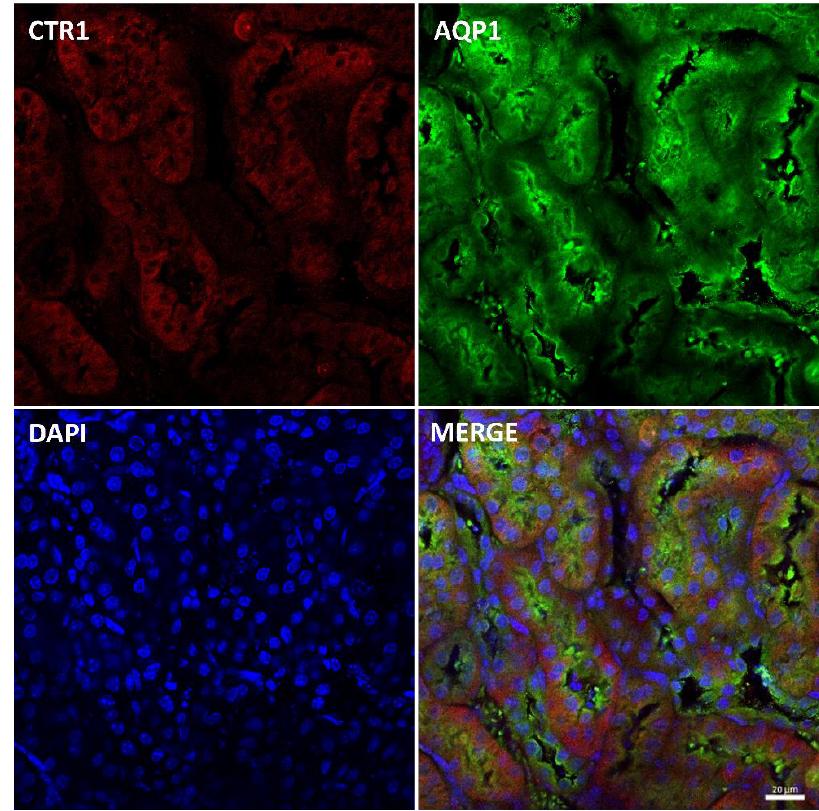
Figure 5. Immunofluorescent staining of CTR1 protein (red, channel) and aquaporin 1 (AQP1), a proximal tubule marker (green channel), in the kidneys of 45-day-old w-t mouse analyzed by confocal microscopy. Localization of both CTR1 and AQP1 in the epithelial cells of the proximal renal tubules. Nuclei were counterstained with DAPI. Bars correspond to 20 μm.